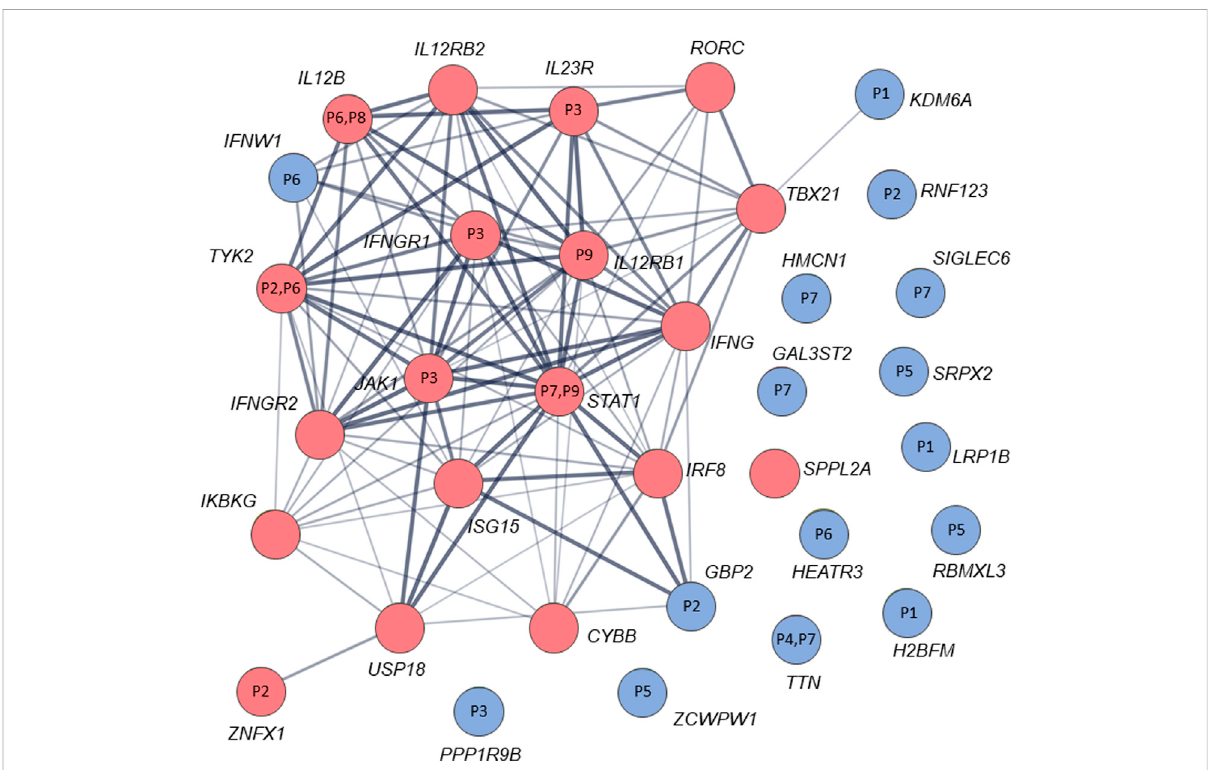
FIGURE 2 STRINGinteraction(network)analysis(https://string-db.org/)between34genes/proteins.Eachcirclerepresentsaprotein/gene:rednodesare known MSMD-causing genes and the blue nodes are novel candidate genes identi fi ed in this study via trio-based approach. Numbers inside the nodesdenotecodesforpatientswithmutationsinthecorrespondinggenes.Interactionsbetweenproteins/genesareindicatedbylineswithvariable thickness showing the strength of data support. The con fi dence cutoff for showing interaction links has been set to ‘ medium ’